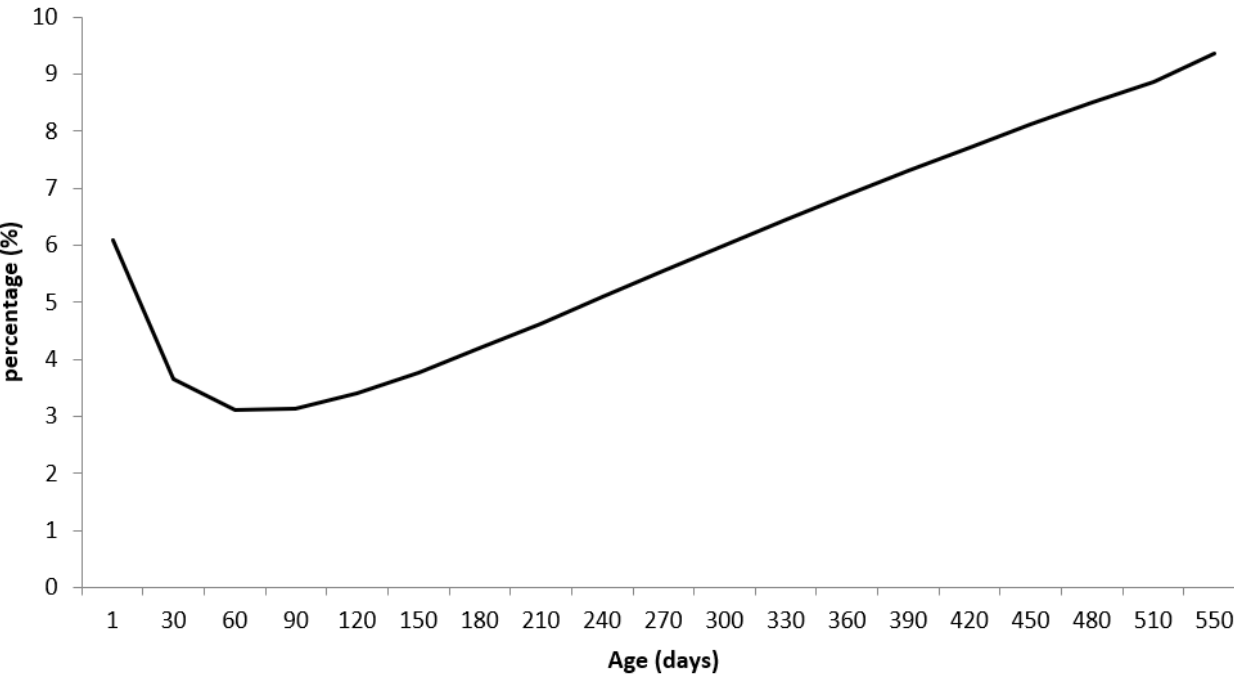
Figure 1. Differences in body weights (in %) between males and females of the Nelore breed, ob- Figure1. Differencesinbody weights(in%)betweenmalesandfemales oftheNelore breed, obtained tained through growth curves by using the Brody function in nonlinear mixed models. through growth curves by using the Brody function in nonlinear mixed